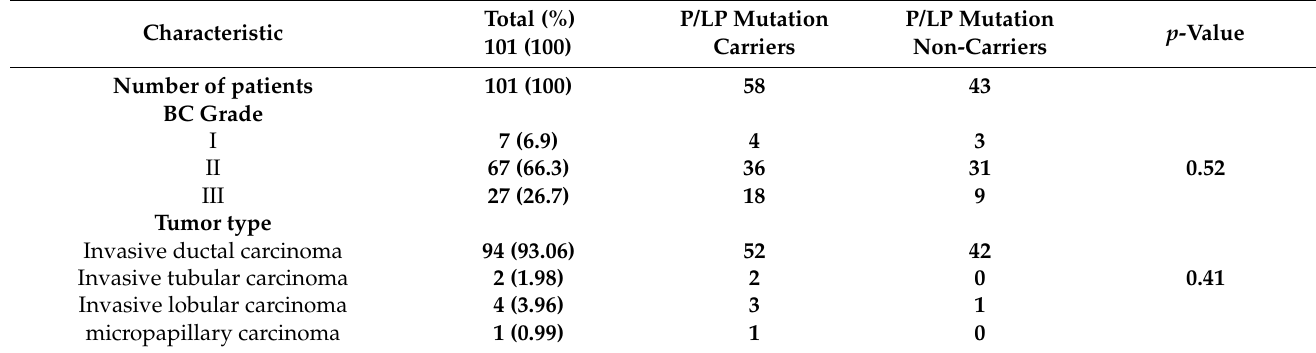
Table 1. Characteristics of patients with and without pathogenic